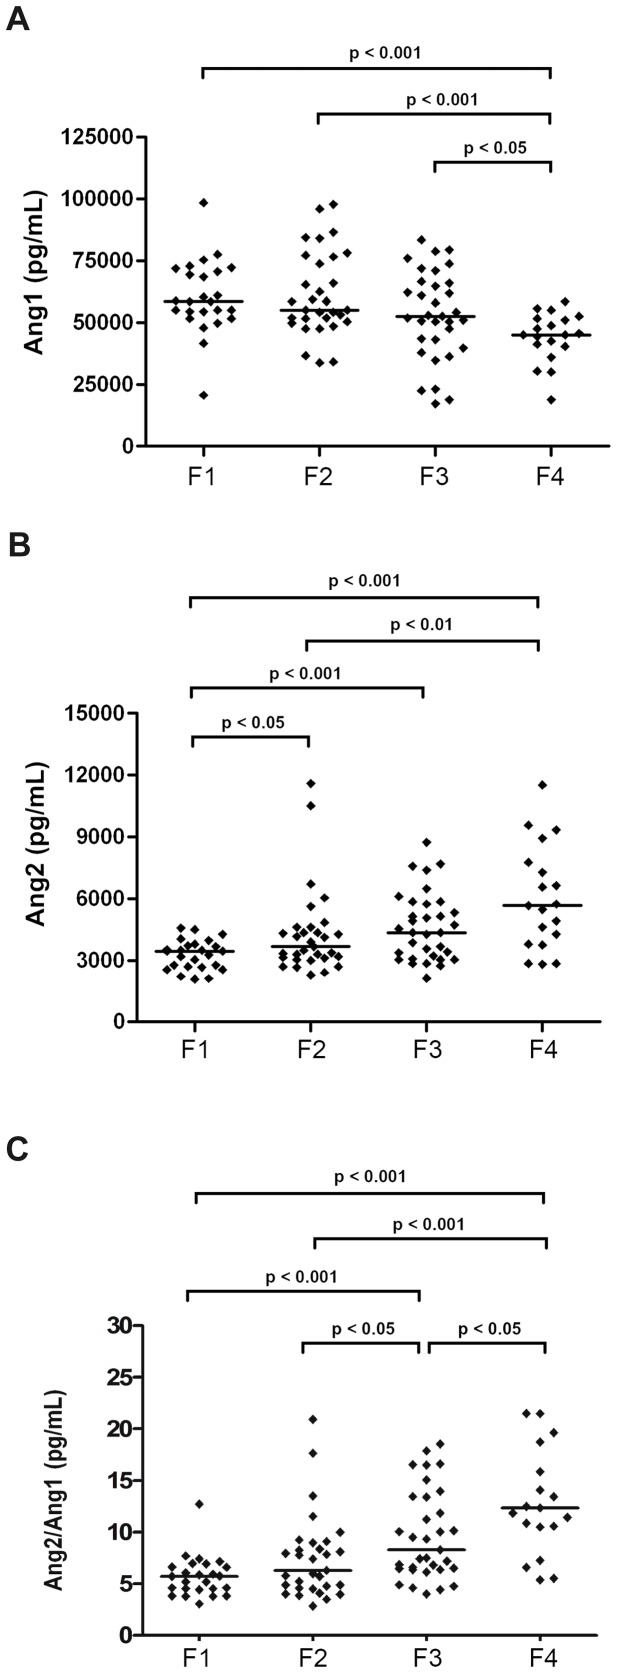
Serum levels of Ang1 and Ang2 in the training set of 108 CHC patients.Distribution of Angiopoietin-1 (A), Angiopoietin-2 (B), and Ang2/Ang1 (C) serum concentrations against METAVIR fibrosis stage. Medians are represented by horizontal lines. Two-sided p-values were calculated by non-parametric Mann-Whitney U Test.